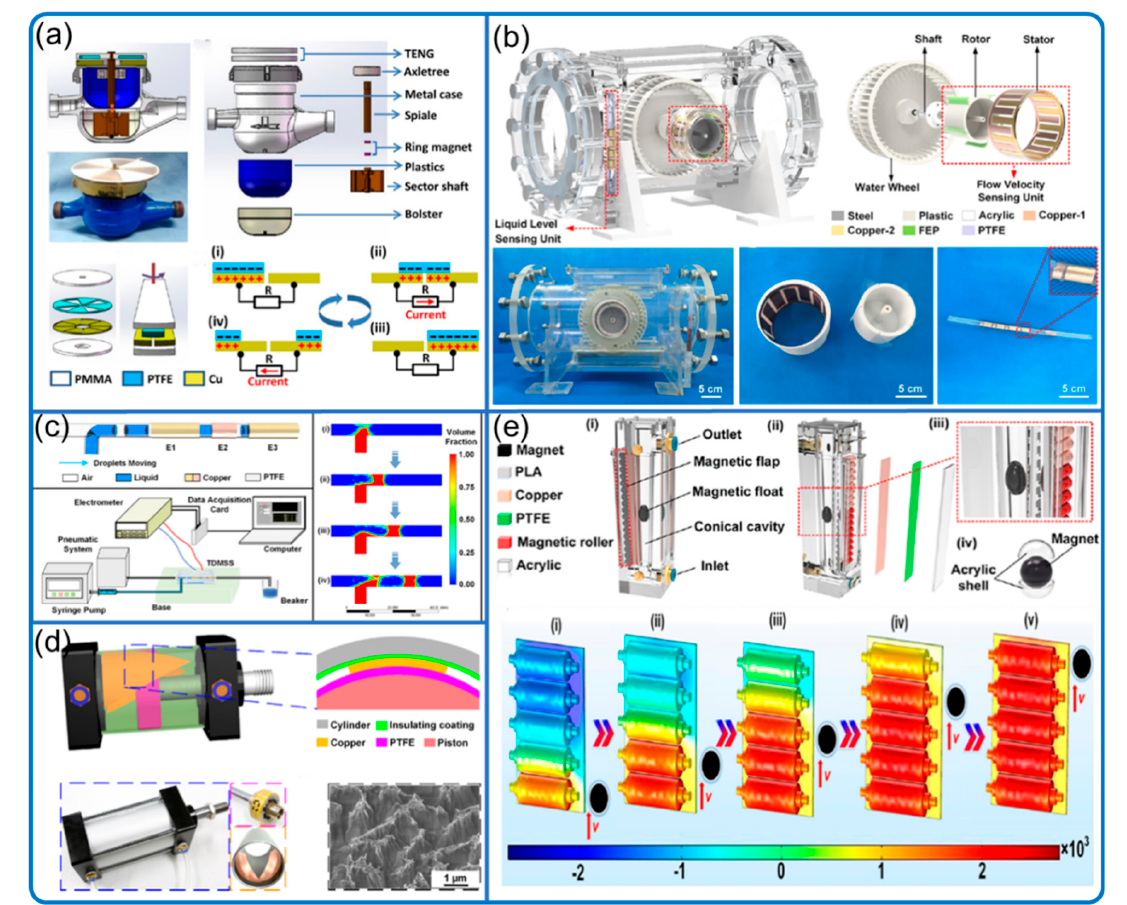
Figure 8. Fluid sensing in pipes and tunnels. ( a ) Anti-rust waterwheel-type system. Reproduced with permission. Copyright 2019, American Chemical Society [58]. ( b ) Non-full pipe fluidic flow and water level system. Reproduced with permission. Copyright 2022, American Chemical Society [59]. ( c ) Non-invasive droplet motion monitoring. Reproduced with permission. Copyright 2021, American Chemical Society [60]. ( d ) Pneumatic monitoring with varied-area electrodes. Reproduced with permission. Copyright 2017, American Chemical Society [63]. ( e ) Magnetic flap-type rotameter-like difunctional sensor. Reproduced with permission. Copyright 2020, American Chemical Society [66].